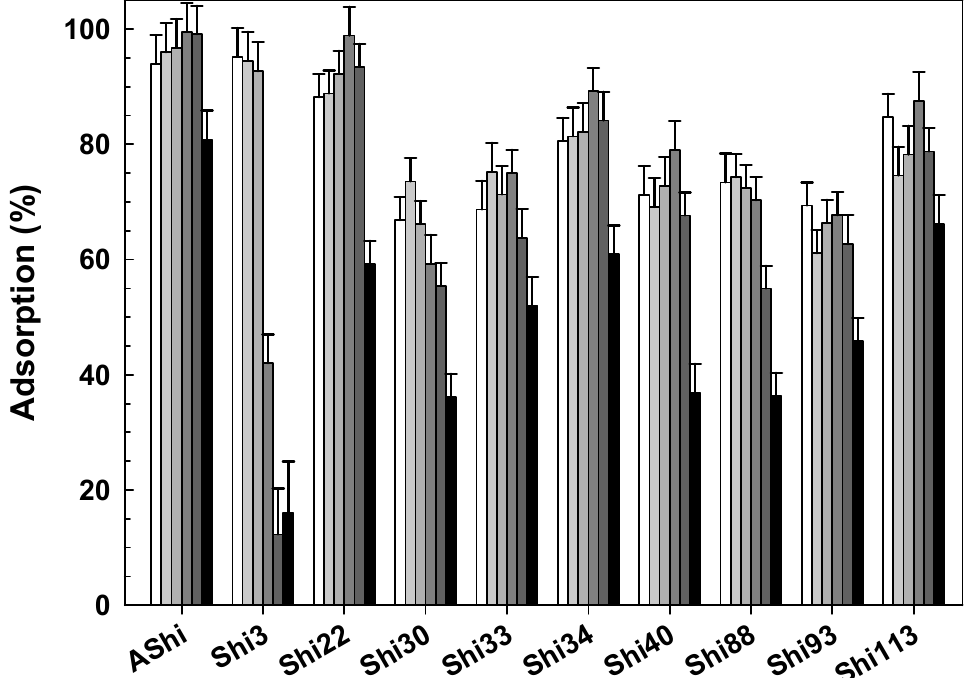
◦ Figure 3. Phage adsorption in TSB at 25 °C (0,5%;  ) with 1.0 g dL − 1 (  ), 2 g dL − 1 (  ), 4 g dL − 1 (  ), Figure 2. Phage adsorption in TSB at 4 °C (  ), 25 °C (  ; control), 37 °C (  ) and 50 °C (  ) on Figure 2. Phage adsorption in TSB at 4 °C (  ), 25 °C (  ; control), 37 °C (  ) and 50 °C (  ) on Figure 3. Phage adsorption in TSB at 25 C (0.5%; Figure 2. Phage adsorption in TSB at 4 °C (  ), 25 °C (  ; control), 37 °C (  ) and 50 °C (  ) on Figure 3. Phage adsorption in TSB at 25 °C (0,5%;  ) with 1.0 g dL − 1 (  ), 2 g dL − 1 (  ), 4 g dL − 1 (  ), 10 g dL − 1 (  ) and 20 g dL − 1 (  ) of Na + on ATCC12022 viable cells. Values are the mean ± standard ATCC12022 viable cells. Values are the mean ± standard deviation (error bars) of three ATCC12022 viable cells. Values are the mean ± standard deviation (error bars) of three ATCC12022 viable cells. Values are the mean ± standard deviation (error bars) of three determina- Figure 2. Phage adsorption in TSB at 4 °C (  ), 25 °C (  ; control), 37 °C (  ) and 50 °C (  ) on 10 g dL − 1 (  ) and 20 g dL − 1 (  ) of Na + on ATCC12022 viable cells. Values are the mean ± standard ) of Na + on ATCC12022 viable cells. Values are the mean ± standard Figure 3. Phage adsorption in TSB at 25 °C (0,5%;  ) with 1.0 g dL − 1 (  ), 2 g dL − 1 (  ), 4 g dL − 1 (  ), deviation (error bars) of three determinations. determinations. determinations. tions. ATCC12022 viable cells. Values are the mean ± standard deviation (error bars) of three deviation (error bars) of three determinations. 10 g dL − 1 (  ) and 20 g dL − 1 (  ) of Na + on ATCC12022 viable cells. Values are the mean ± standard deviation (error bars) of three determinations. deviation (error bars) of three determinations.